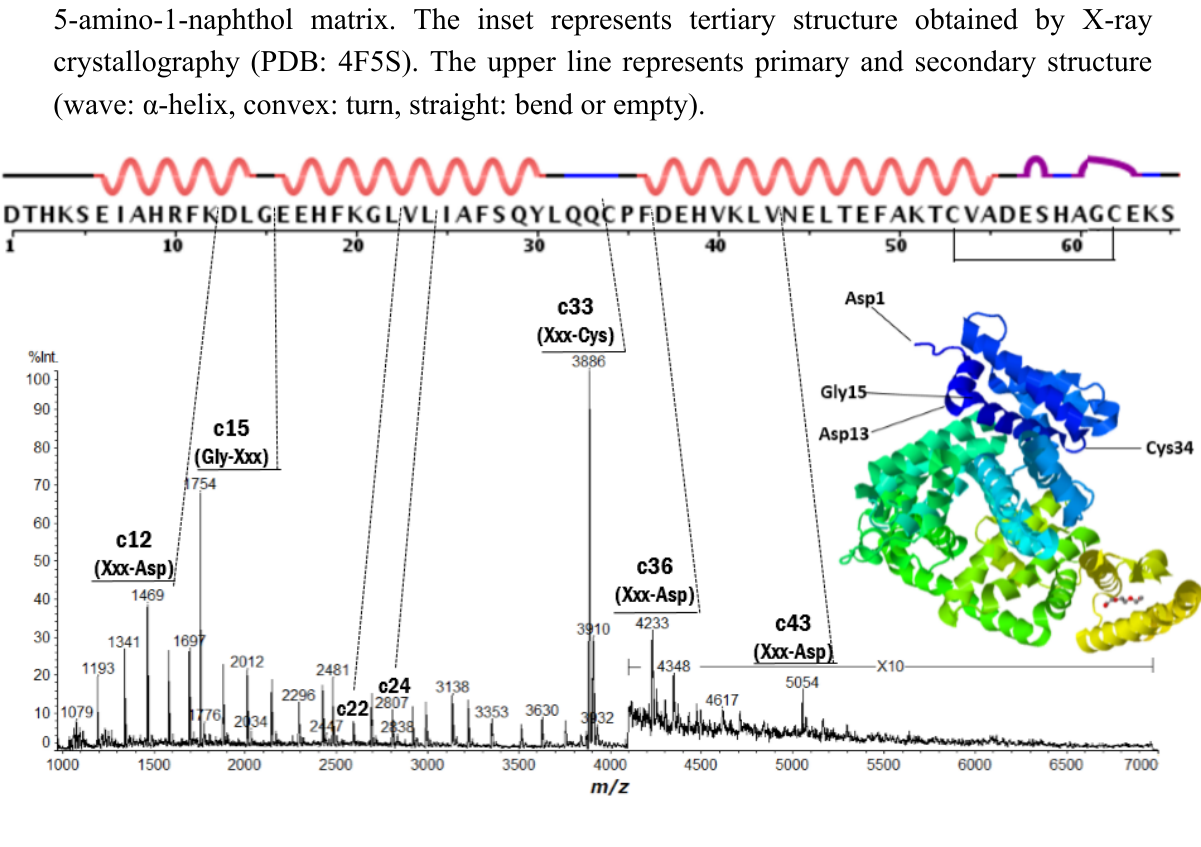
Figure 1. Positive ion matrix-assisted laser desorption/ionization in-source decay (MALDI-ISD) spectrum of bovine serum albumin ( M r 66430.3) obtained